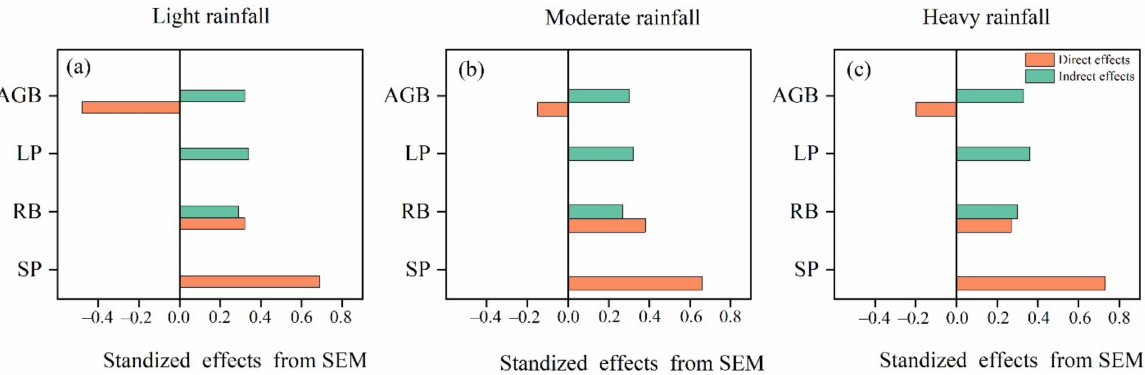
Figure 7. Standardized effects on the CRSW derived from the structural equation modeling (SEM). The orange and green bars represent the direct and indirect effects of various factors on the con- tribution of ( a ) light rainfall, ( b ) moderate rainfall and ( c ) heavy rainfall to soil water from SEM. AGB: above-ground biomass; LP: litter properties; SP: soil properties and RB: root